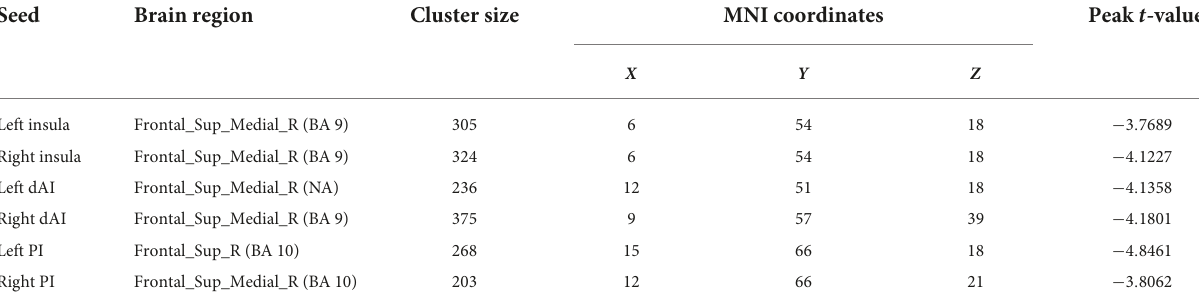
TABLE 2 Brain regions showing significant differences in functional connectivity with insula or its subregions between PNE and HC children.